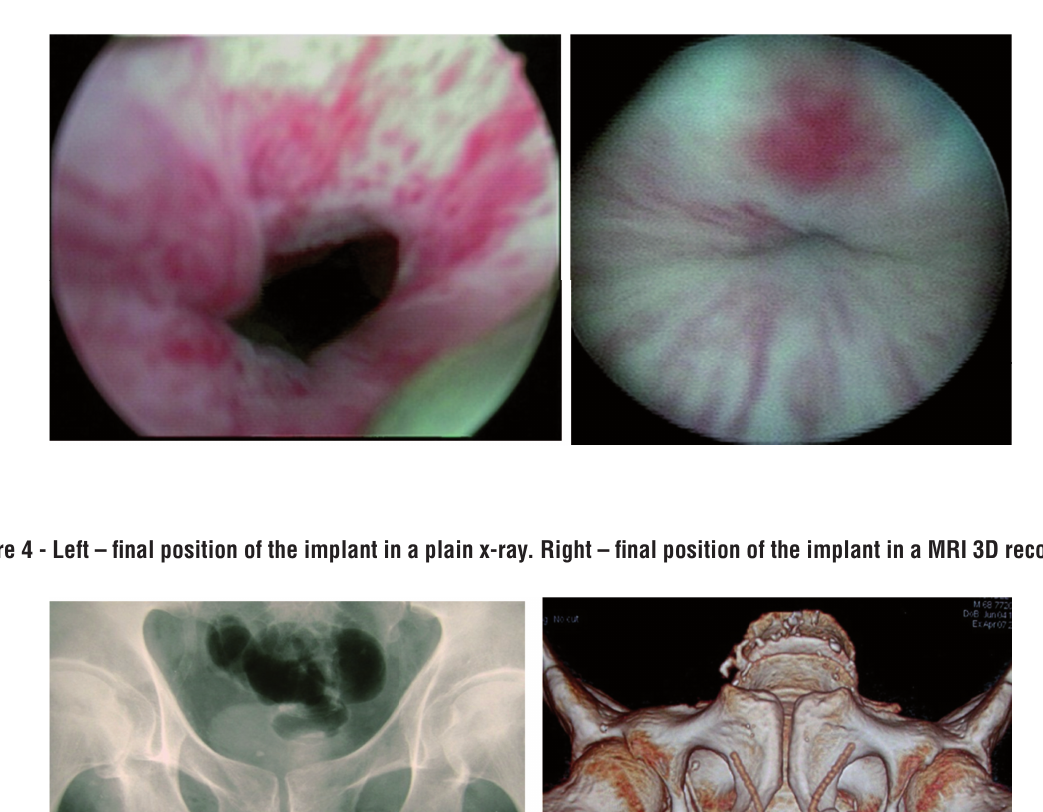
Figure 3 - Left – urethral lumen before the procedure. Right – urethral lumen after RLPP adjust.